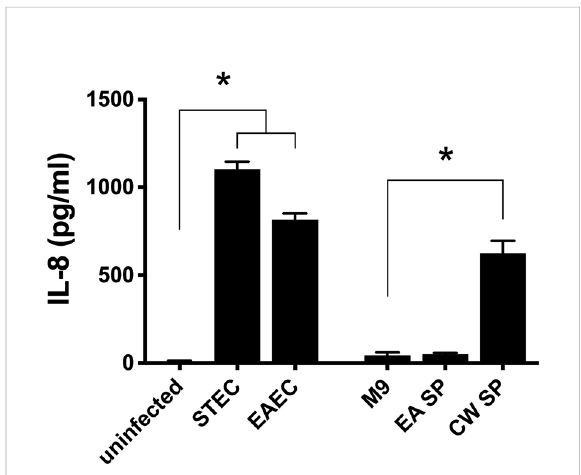
FIGURE 2 Induction of IL-8 secretion by bacteria used in this